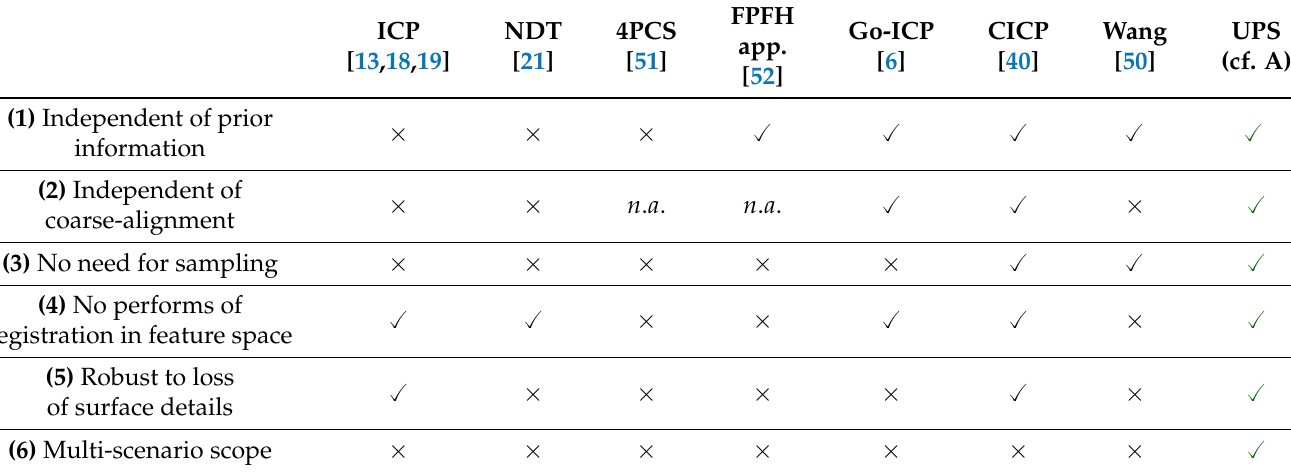
Table 13. Qualitative comparison of algorithms for point clouds registration. Note: n.a. stands for not